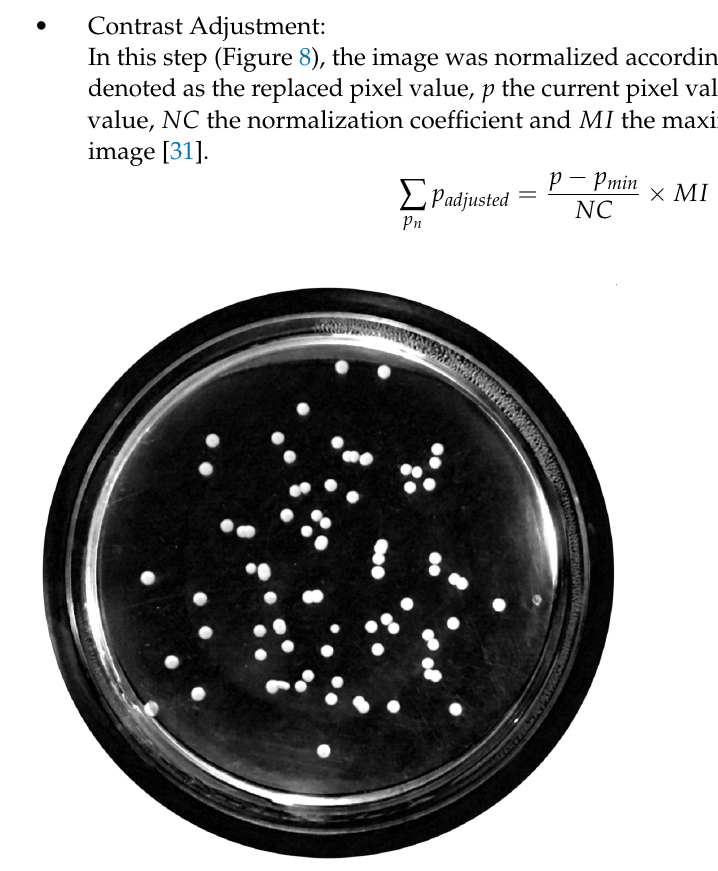
Figure 8. Contrast